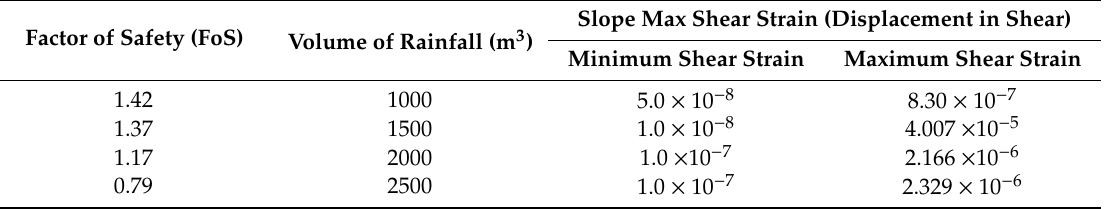
Table 5. General results of FLACSlope simulations in clay soil slope.